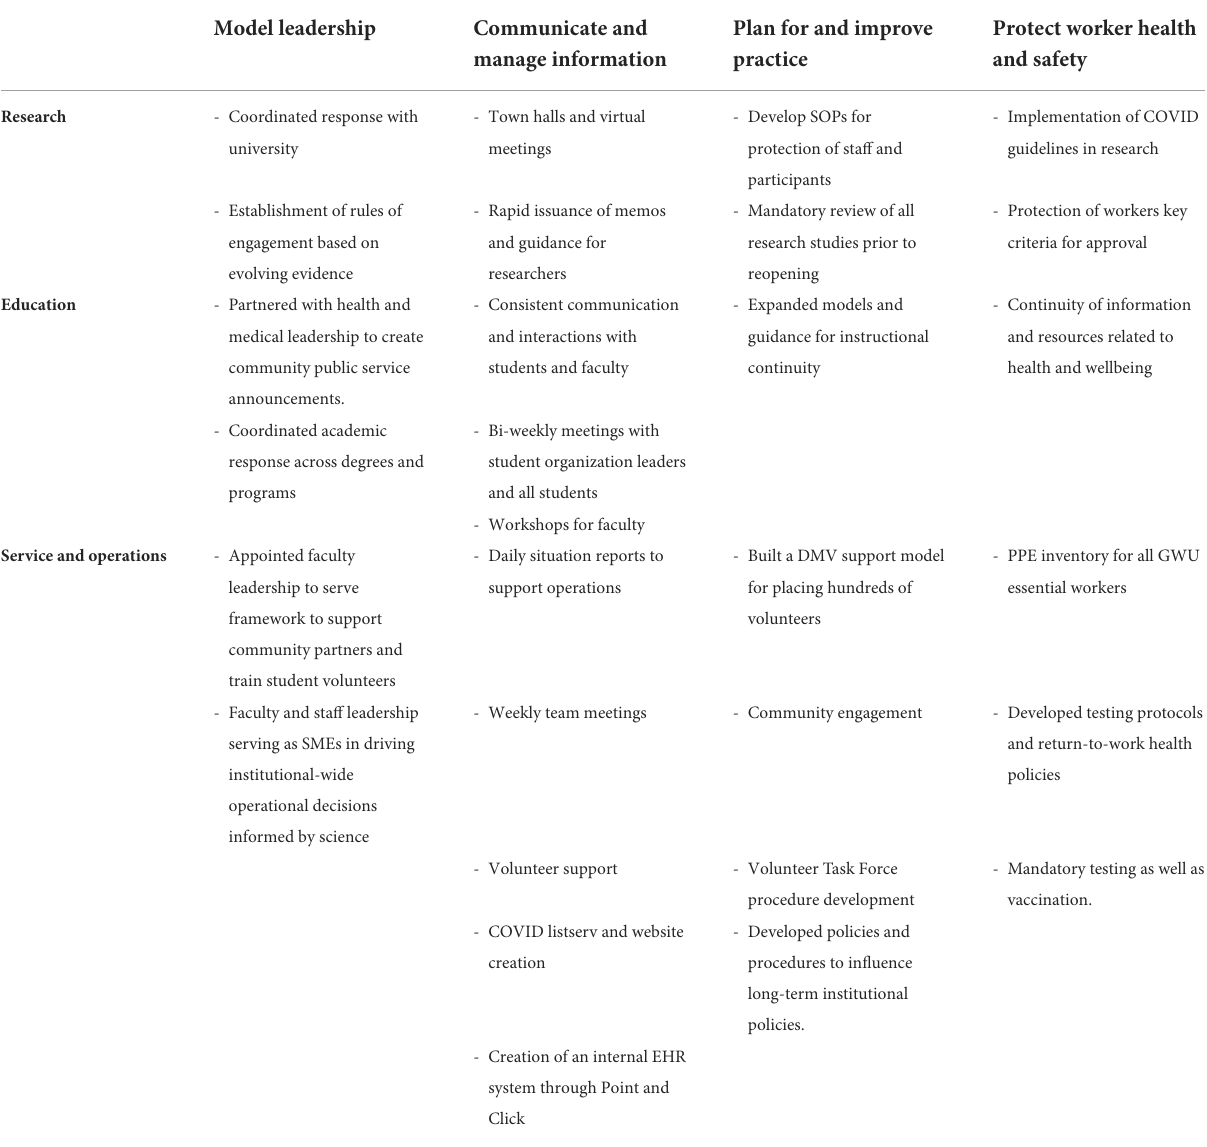
TABLE 2 The framework and GWSPH